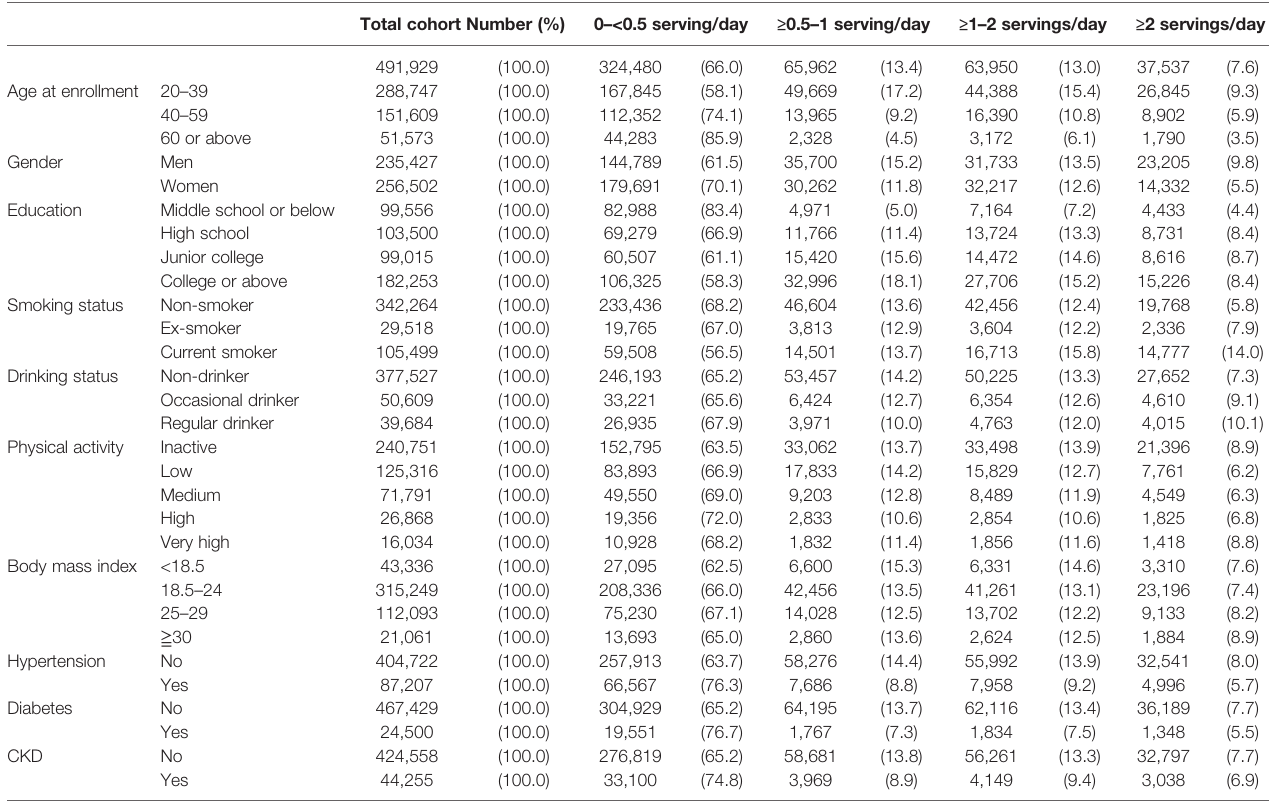
TABLE 1 | The population distribution of sugar-sweetened beverages